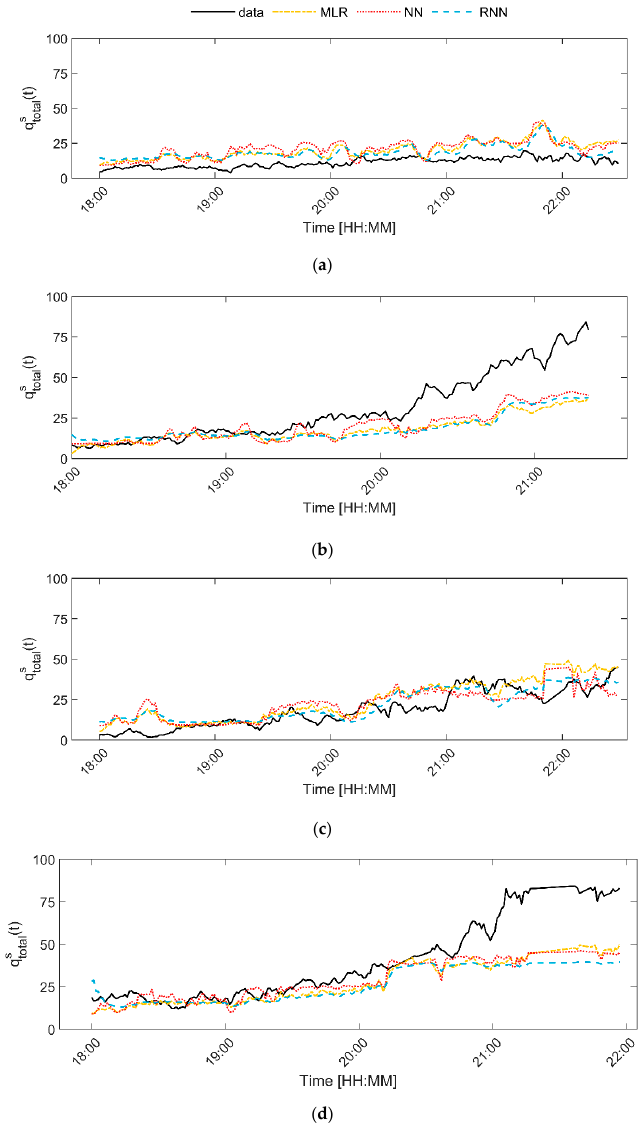
Figure 6. Comparison of simulated and measured flow rate time series for several locations and days, where ( a ) locations 2—Thursday, ( b ) location 4—Thursday, ( c ) location 2—Saturday, and ( d ) location